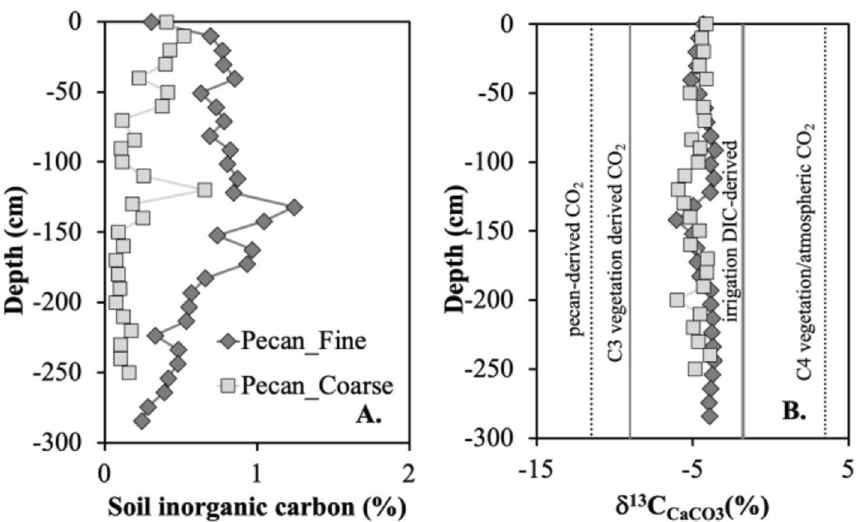
Figure 5. Depth profiles of soil inorganic carbon concentrations ( A ) and carbon isotopes (δ 13 C CaCO3 ) ( B ) at the Pecan_Fine and Pecan_Coarse sites. Vertical dotted in ( B ) are δ 13 C CaCO3 values of natural pedogenic carbonates at equilibrium with natural C3 or C4 types of vegetation. The δ 13 C CaCO3 at equilibrium with atmospheric CO 2 overlaps with that of typical C4 vegetation. The solid lines are δ 13 C CaCO3 of anthropogenic pedogenic carbonates at equilibrium with DIC in irrigation water and with organic matter of the pecan